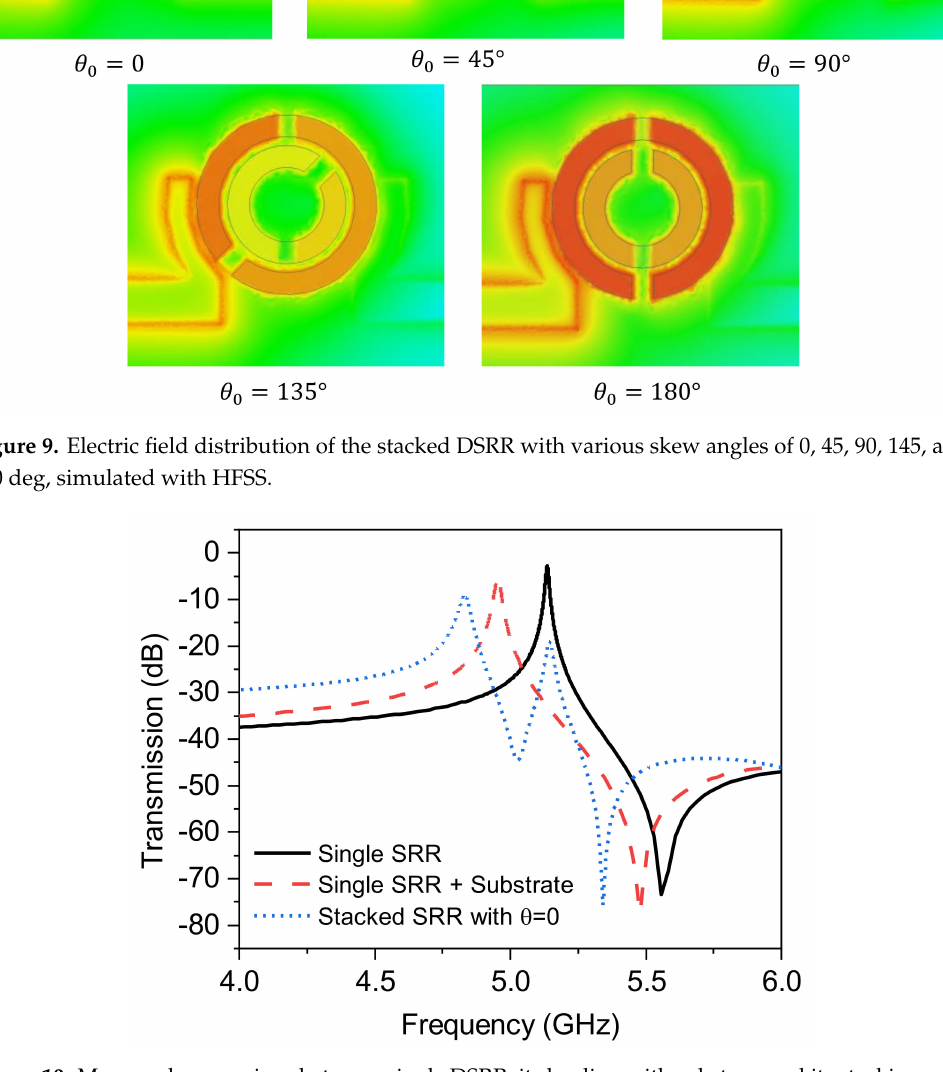
Figure 10. Measured comparison between single DSRR, its loading with substrae, and its stacking with a DSRRat θ 0 = 0 ◦